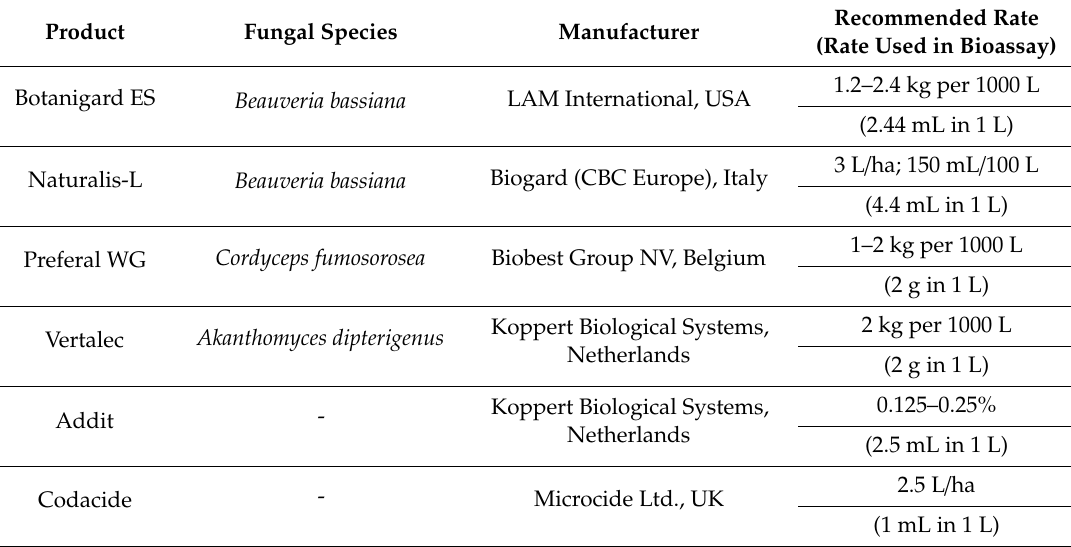
Table 2. Crop protection products used in this